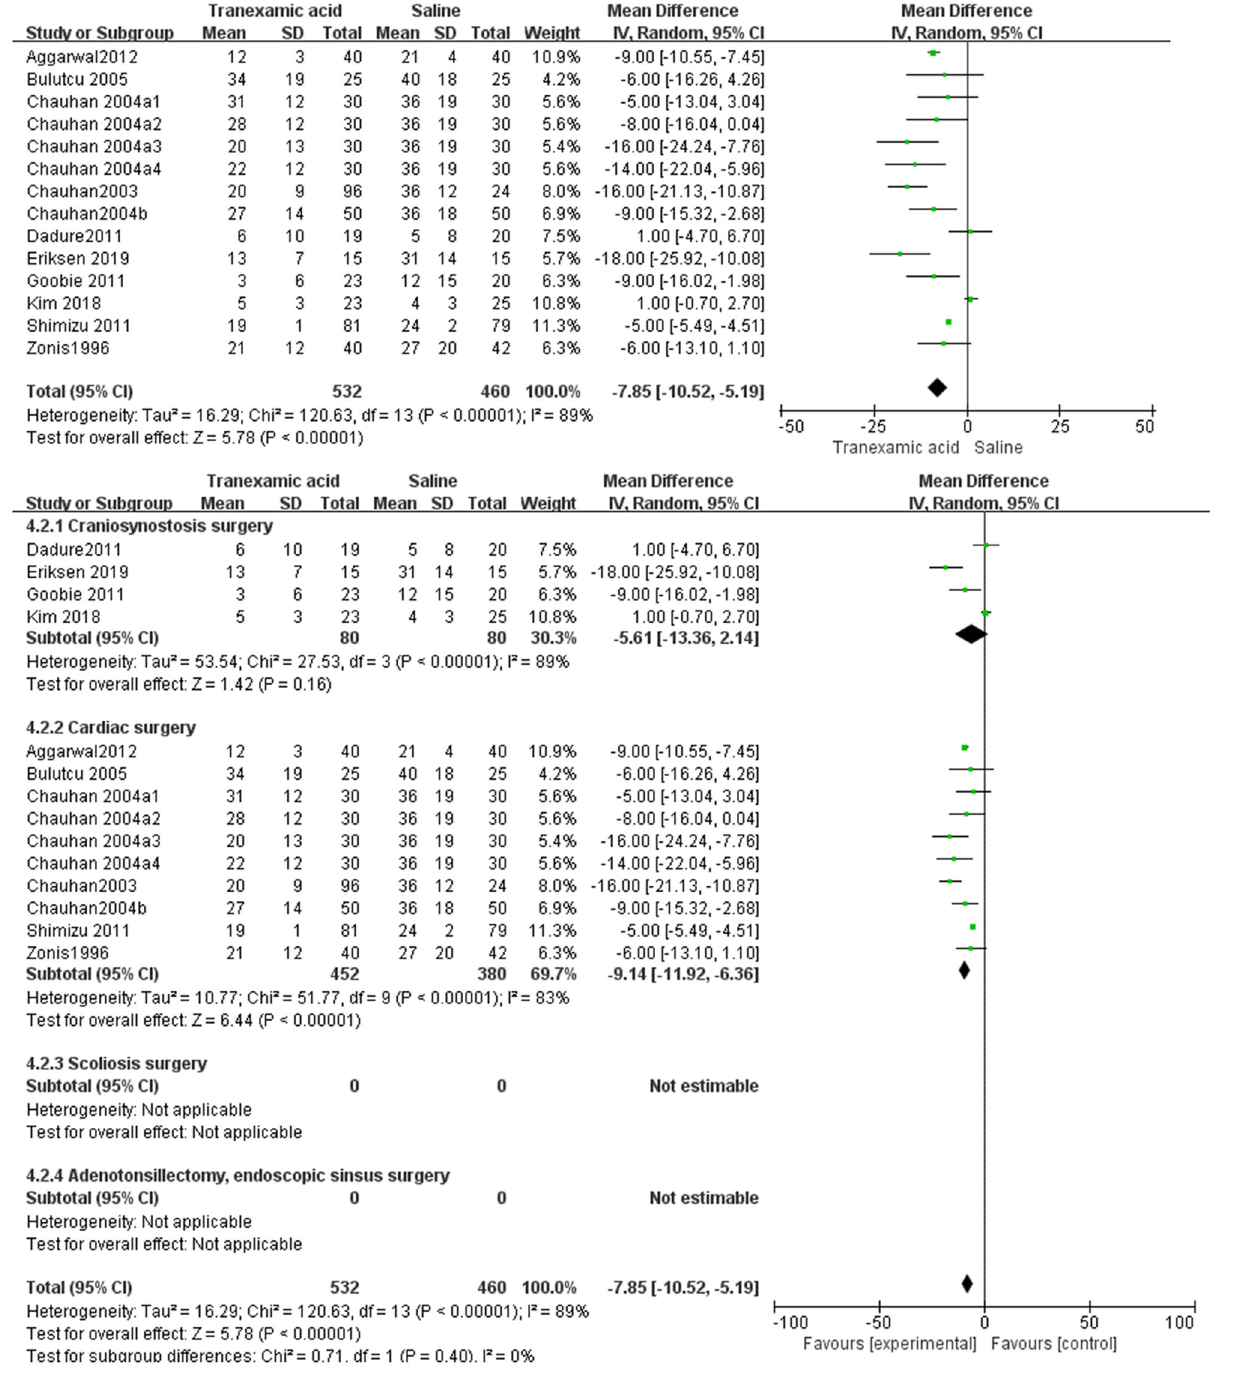
FIGURE 4 | Meta-analysis of blood loss at 24h after surgery for TXA compared with